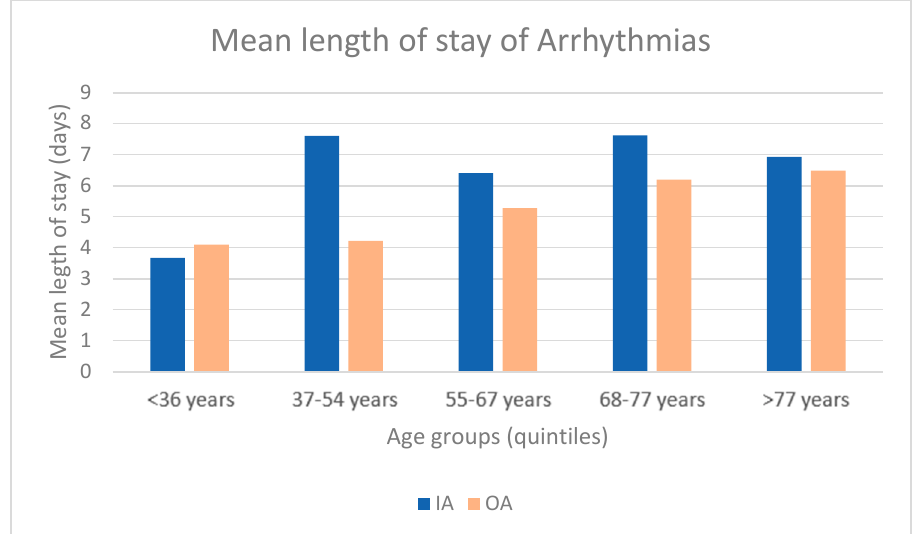
Figure 4. Comparison of the mean length of stay of Arrhythmias and OA (2018–2021).